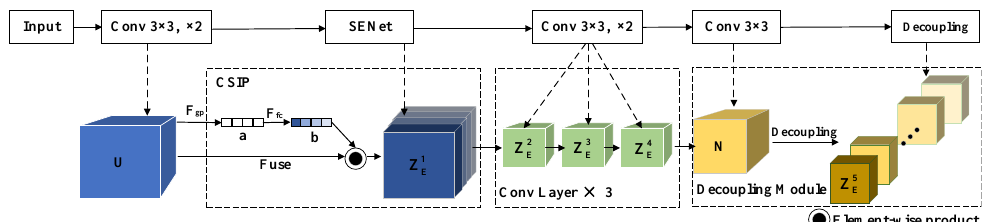
Figure 2. Encoder with CSIP and decoupling